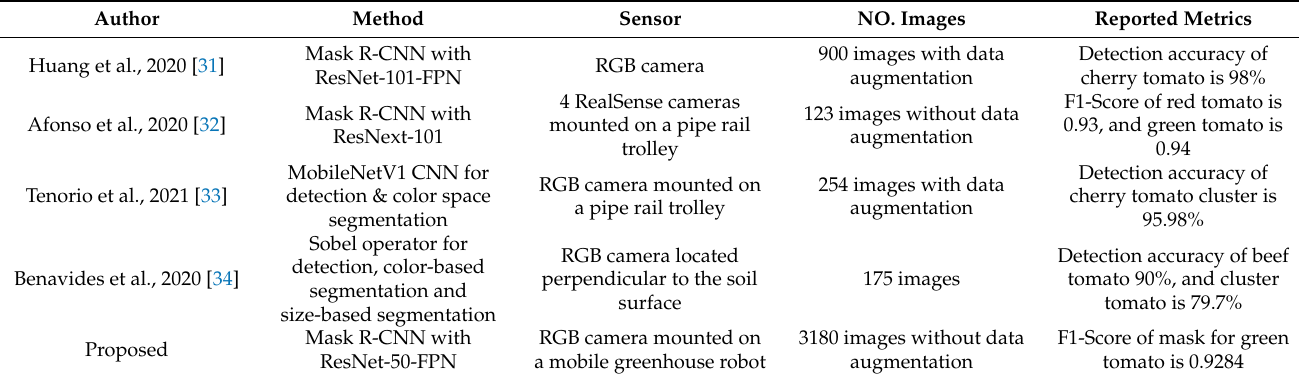
Table 3. Scientific studies in tomato detection and segmentation based on image